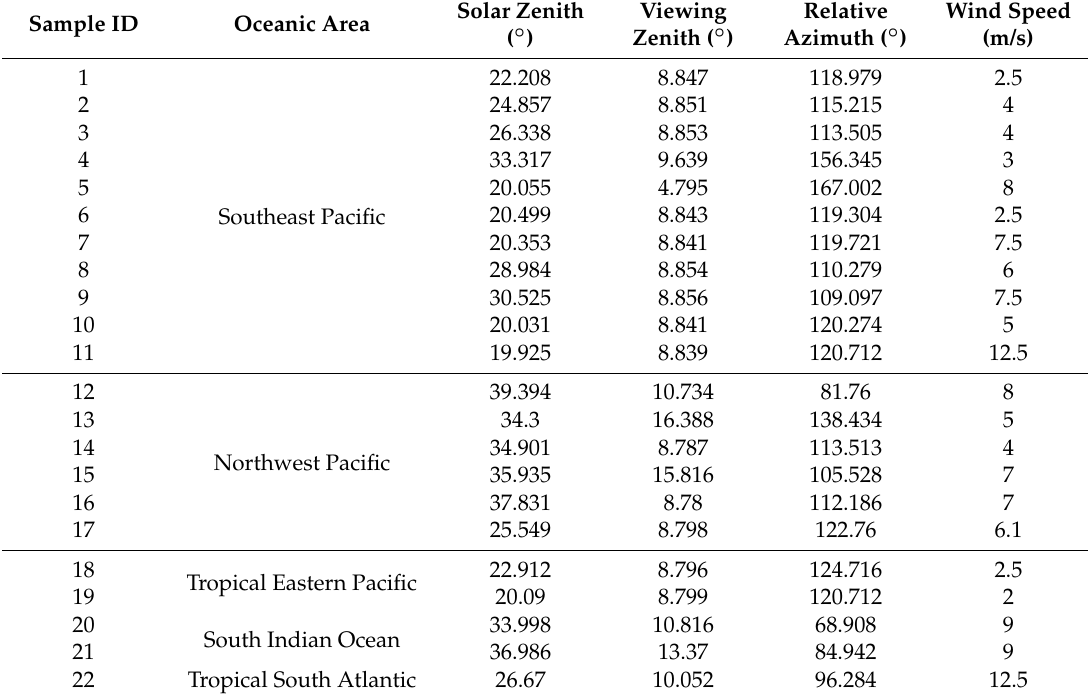
Table 2. The solar and viewing geometries as well as wind speed for the 22